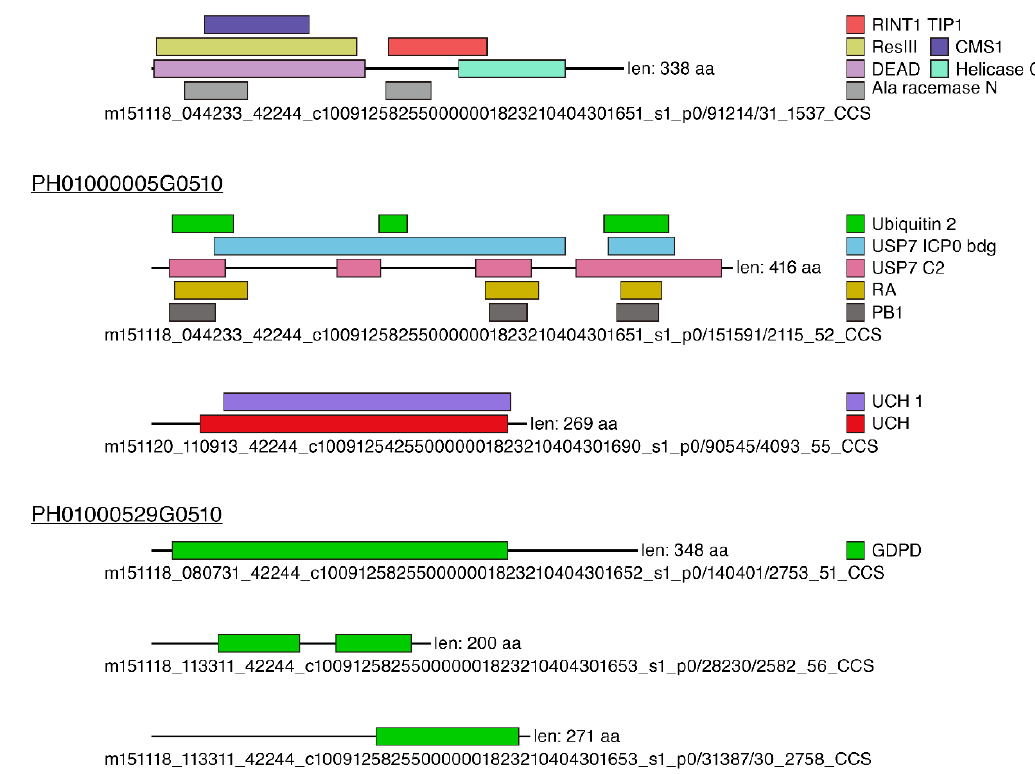
Figure 6. Different protein isoforms from the same locus were identified by mass spectrometry data. ( A ) The pipeline for the verification of different protein isoforms from the same locus for moso bamboo through protein profiling data; ( B ) The Venn diagram illustrating the number of different protein isoforms verified by mass spectrometry in all AS/APA isoform; ( C ) Domain analysis of different protein isoforms from the same locus.